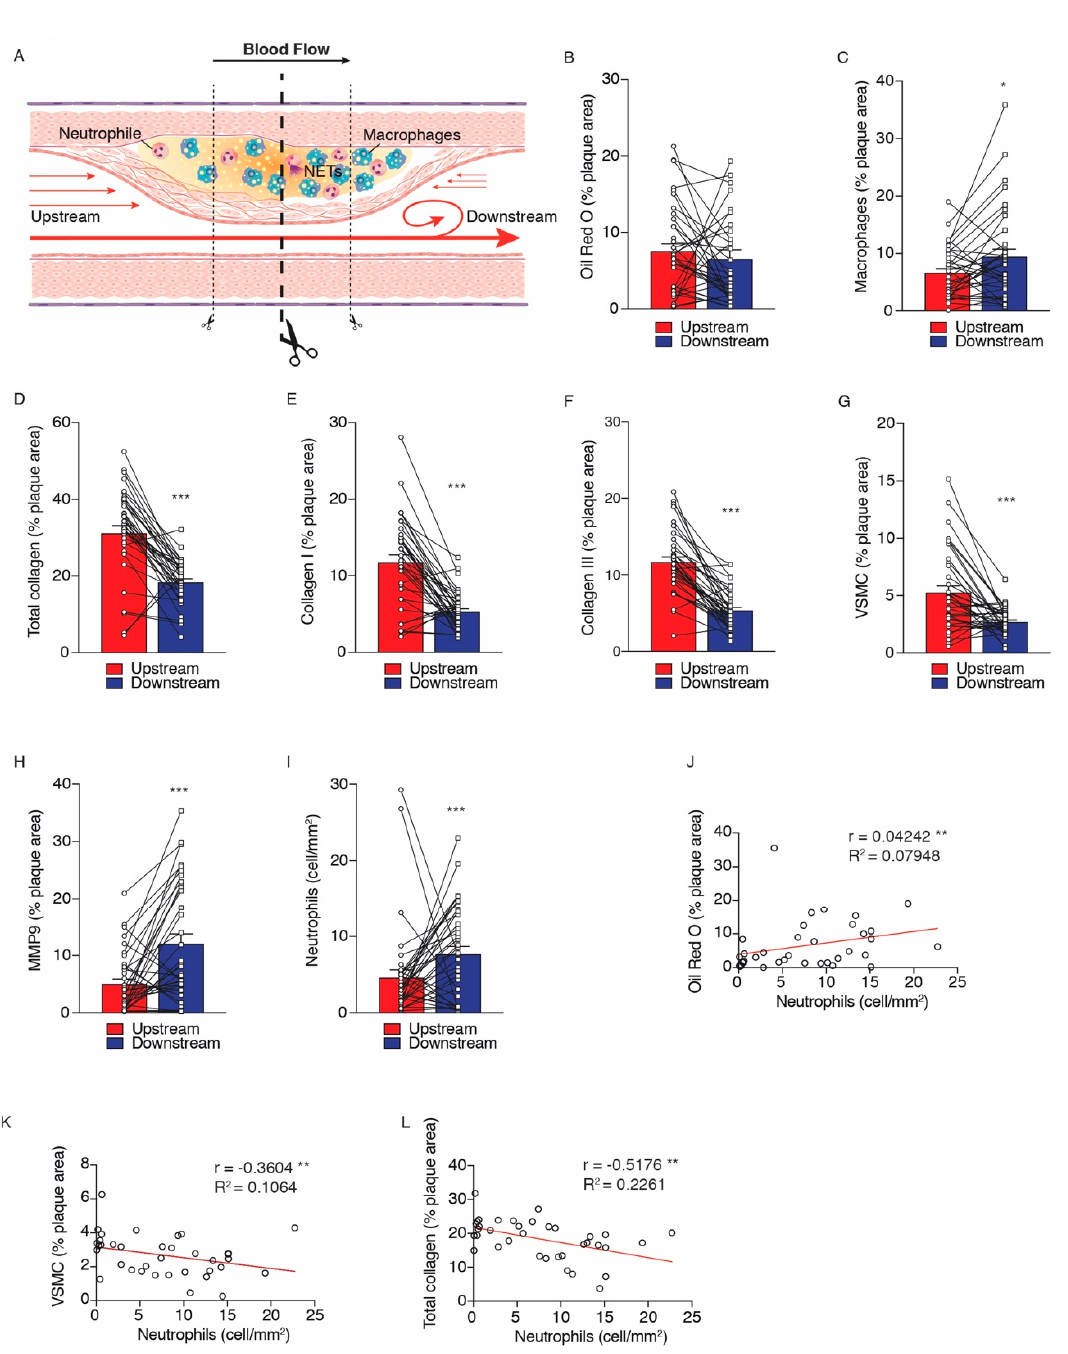
Figure 1. Distinct atherosclerotic plaque composition of upstream versus downstream regions of human carotid artery plaques. ( A ) Representative scheme of sample collection of human carotid plaques located upstream and downstream to the blood flow regions. Bar graph represents the average of immunohistochemistry signal of ( B ) Oil Red O, ( C ) macrophage, ( D ) total collagen, ( E ) collagen I, ( F ) collagen III, ( G ) VSMC, ( H ) MMP-9, and ( I ) neutrophil upstream (red bars) and downstream (blue bars) to the blood flow plaque regions. Spearman’s rank correlation coefficients between Oil Red O ( J ), VSMC ( K ), total collagen ( L ), and neutrophils. Data were expressed as mean ± SEM. n = 36 patients for each atherosclerotic region. * p < 0.05, ** p <0.01 and *** p <0.001 Wilcoxon Matched Pairs test.